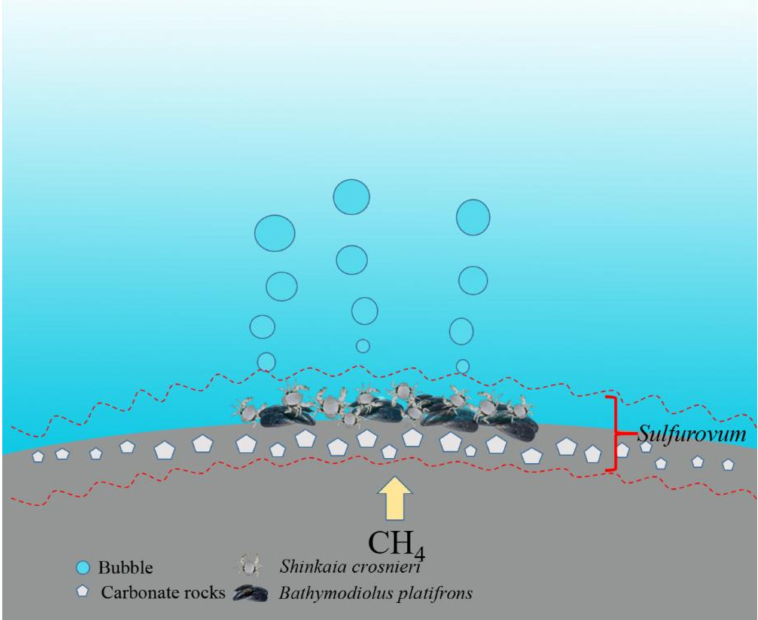
Figure 10. A sketch of Sulfurovum distribution in the seawater–sediment interface of Formosa cold seep